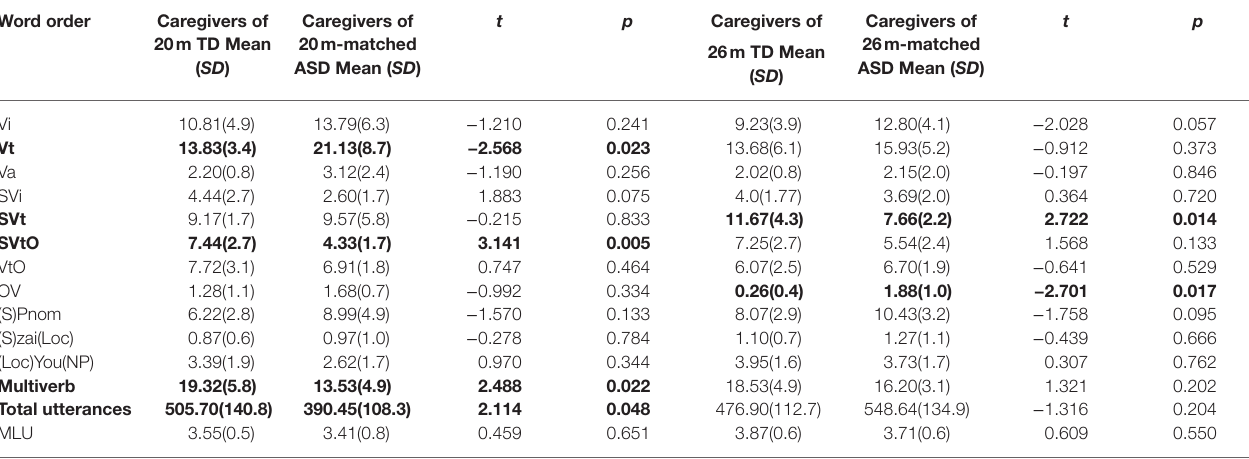
TABLE 8 | Between-group comparison of word order utterances (Caregiver; percent of utterances). Word